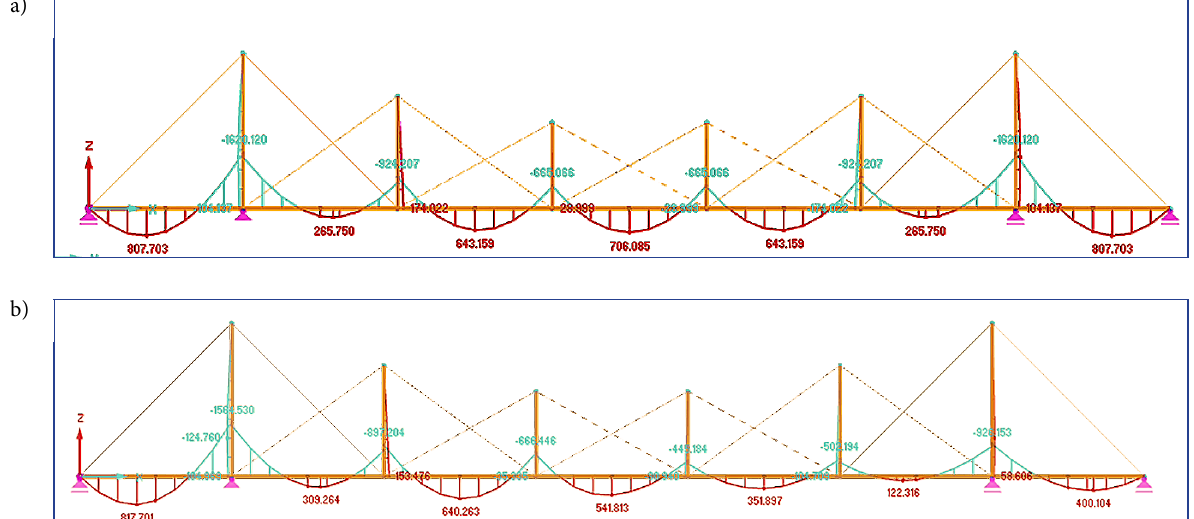
Figure 6. Varying pylons bridge. Bending moments: a) under symmetrical loading; b) under